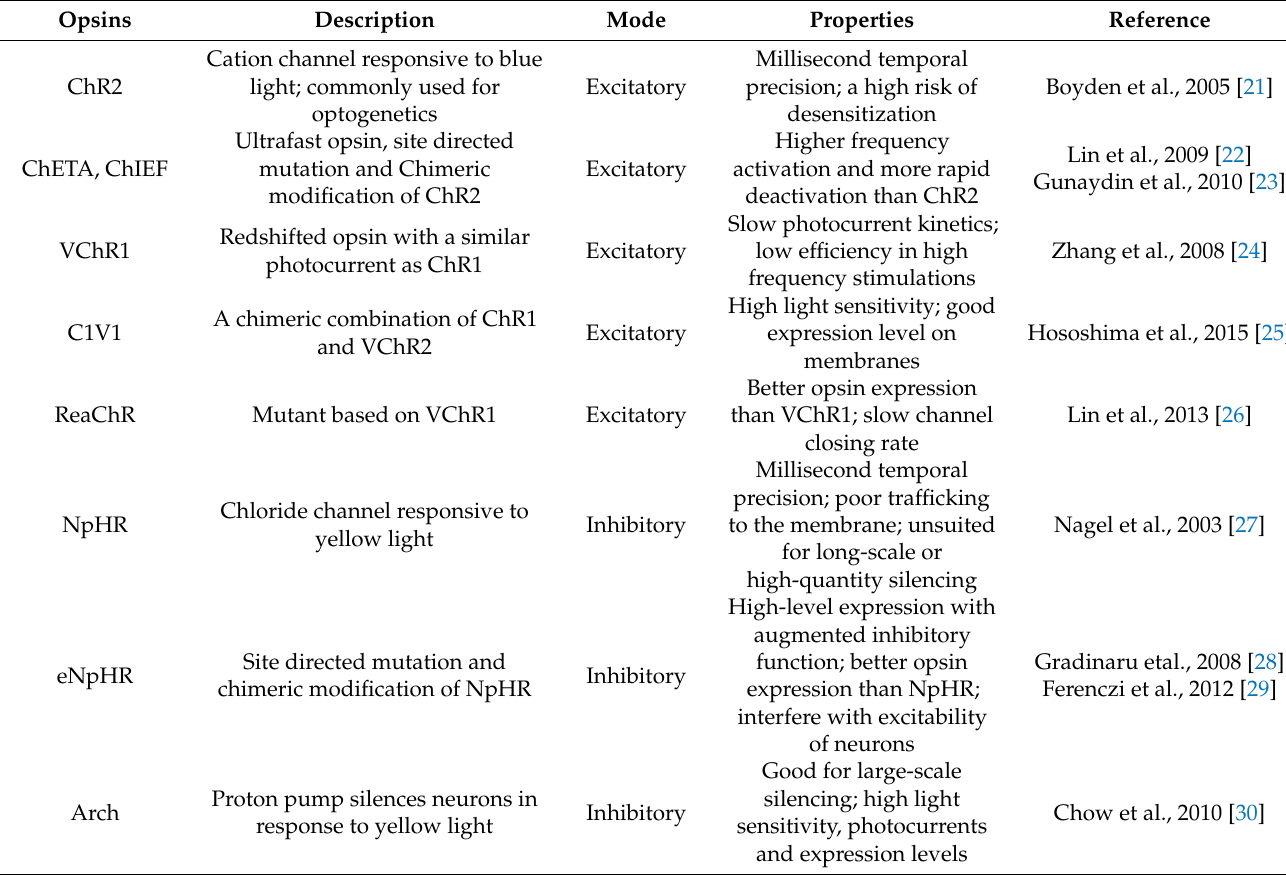
Table 1. Commonly Used Optogenetic